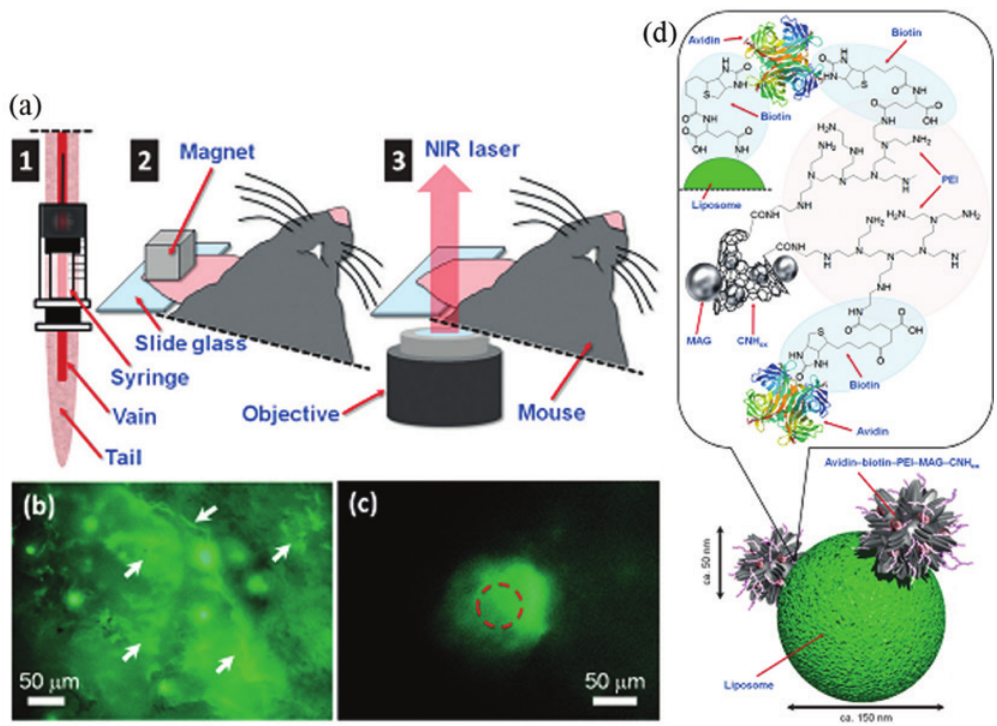
Figure 13: In vivo remote control of enzymatic reactions using nanotransporters. (A) Schematic image of the experiment. (1): injection of nanotransporters, (2): Nanotransporters accumulated by a magnet, (3): Manipulation and observation of physicochemical aspects of nanotransporters with NIR radiation. (B) Accumulation of nanotransporters in the vessels by magnetic field. (C) In vivo β -Gal reaction observed in the blood vessel of a living mouse. (D) Nanotransporter structure. Reprinted with permission from Ref. [188], copyright 2016, John Wiley & Sons,